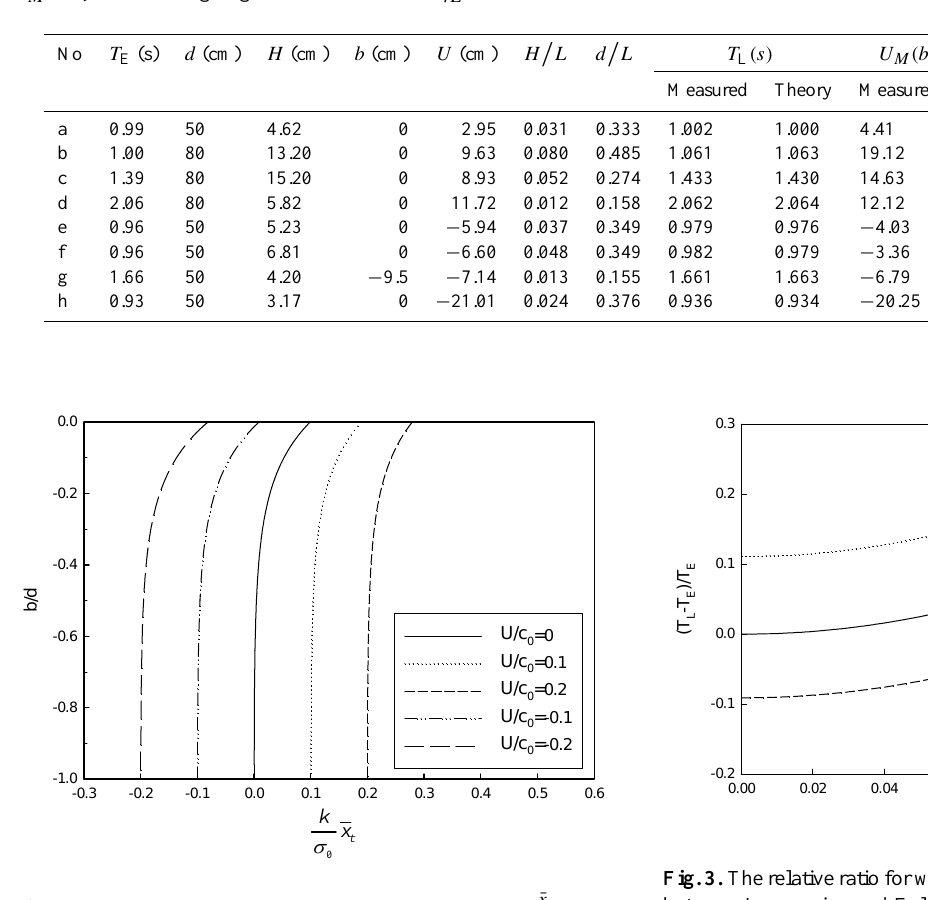
Fig. 2. The dimensionless mass transport velocity profile ¯ x t relative water depth d/L = 0 . 5 and the relative wave height H/L = Figure 2. The dimensionless mass transport velocity profile 0 . 1 under various current conditions.